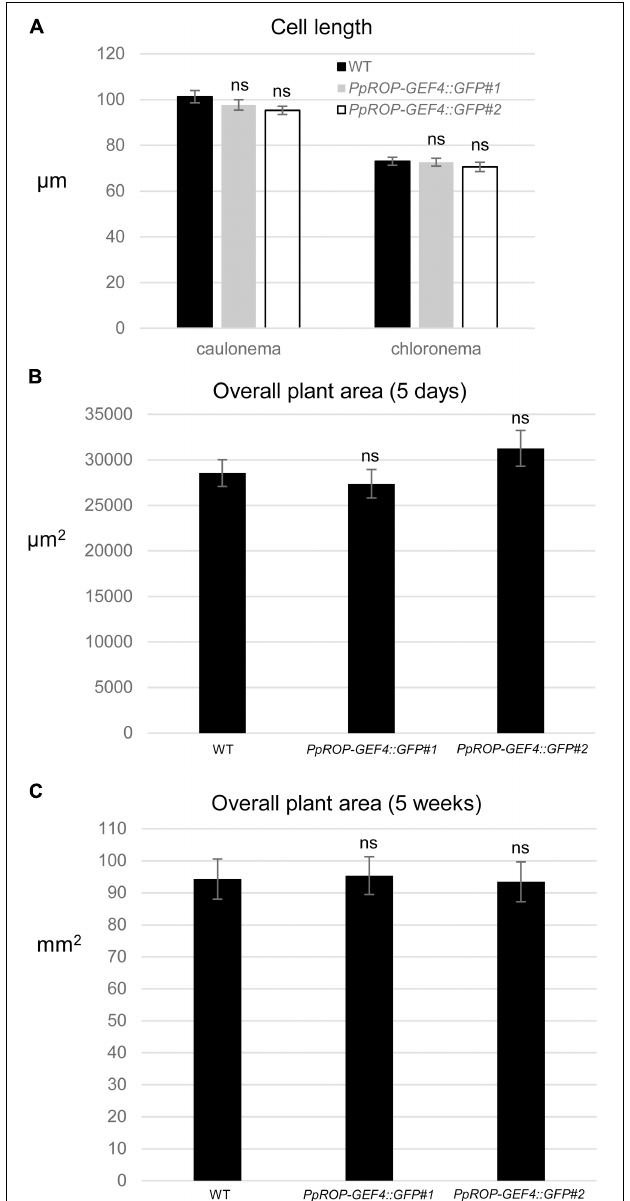
FIGURE 4 | Quantitative comparison of the growth of WT and PpROP-GEF4::GFP “knock-in” plants. (A) Length of fully expanded first subapical cells of 5-day-old protonemata. (B) Total area of 5-day-old protonemata. (C) Total area of 5-week-old plants. The statistical significance of differences between WT and other data sets was assessed using ANOVA (Bonferroni-Holm, one factor). ns: not significantly different. Error bars: standard error of the mean.